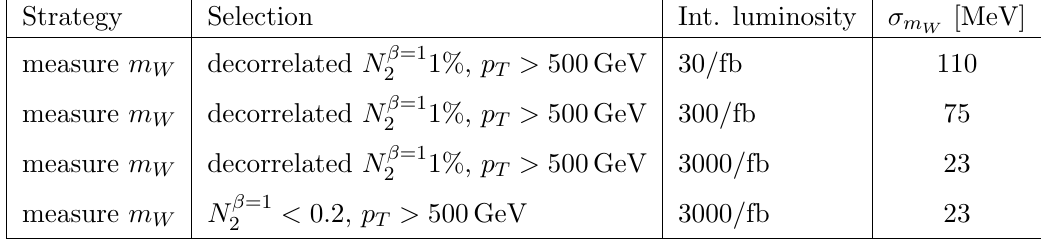
Table 1 . Statistical uncertainty of an m W mass measurement for di(cid:11)erent